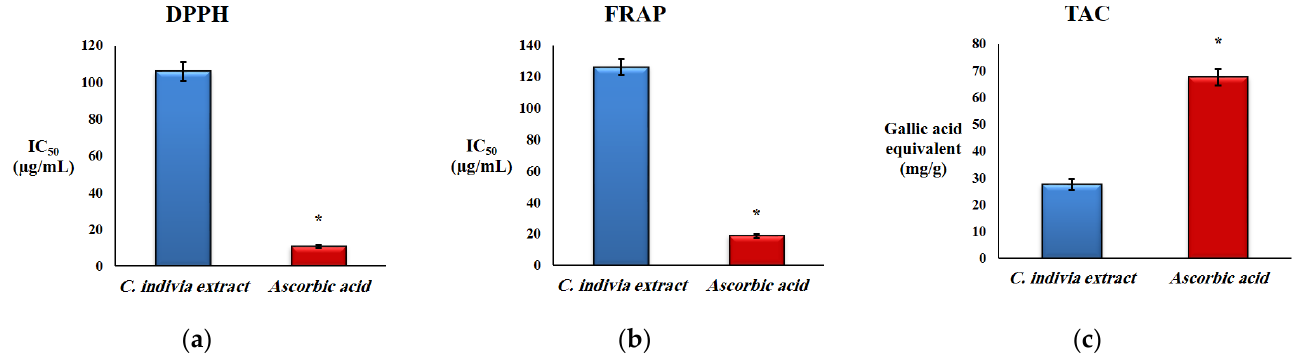
Figure 2. Antioxidant activity of C. endivia L. crude extract: ( a ) the IC 50 value of DPPH radical scavenging assay; ( b ) the IC 50 value of FRAP scavenging assay; and ( c ) total antioxidant capacity (TAC) assay. Results are expressed as mean ± SD and compared by Student t test. * Significantly different compared to C. endivia crude extract at p < 0.05.